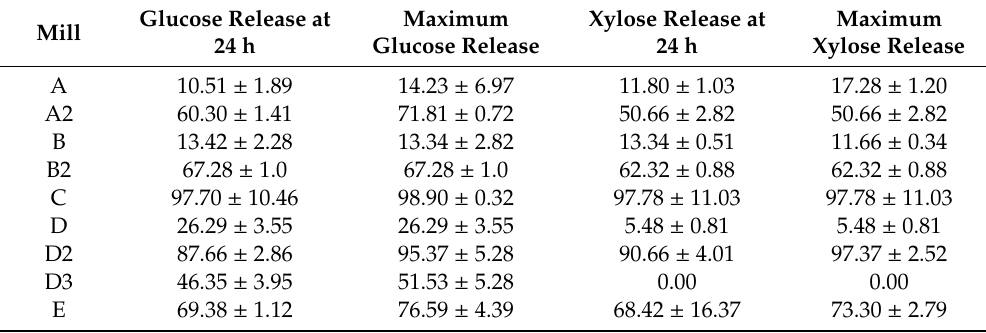
Table 3. Enzyme hydrolysis yield (Cellulose-to-glucose and Xylan to Xylose (wt%) ( ± S.D.)) ( n = 3). Glucose Release Mill